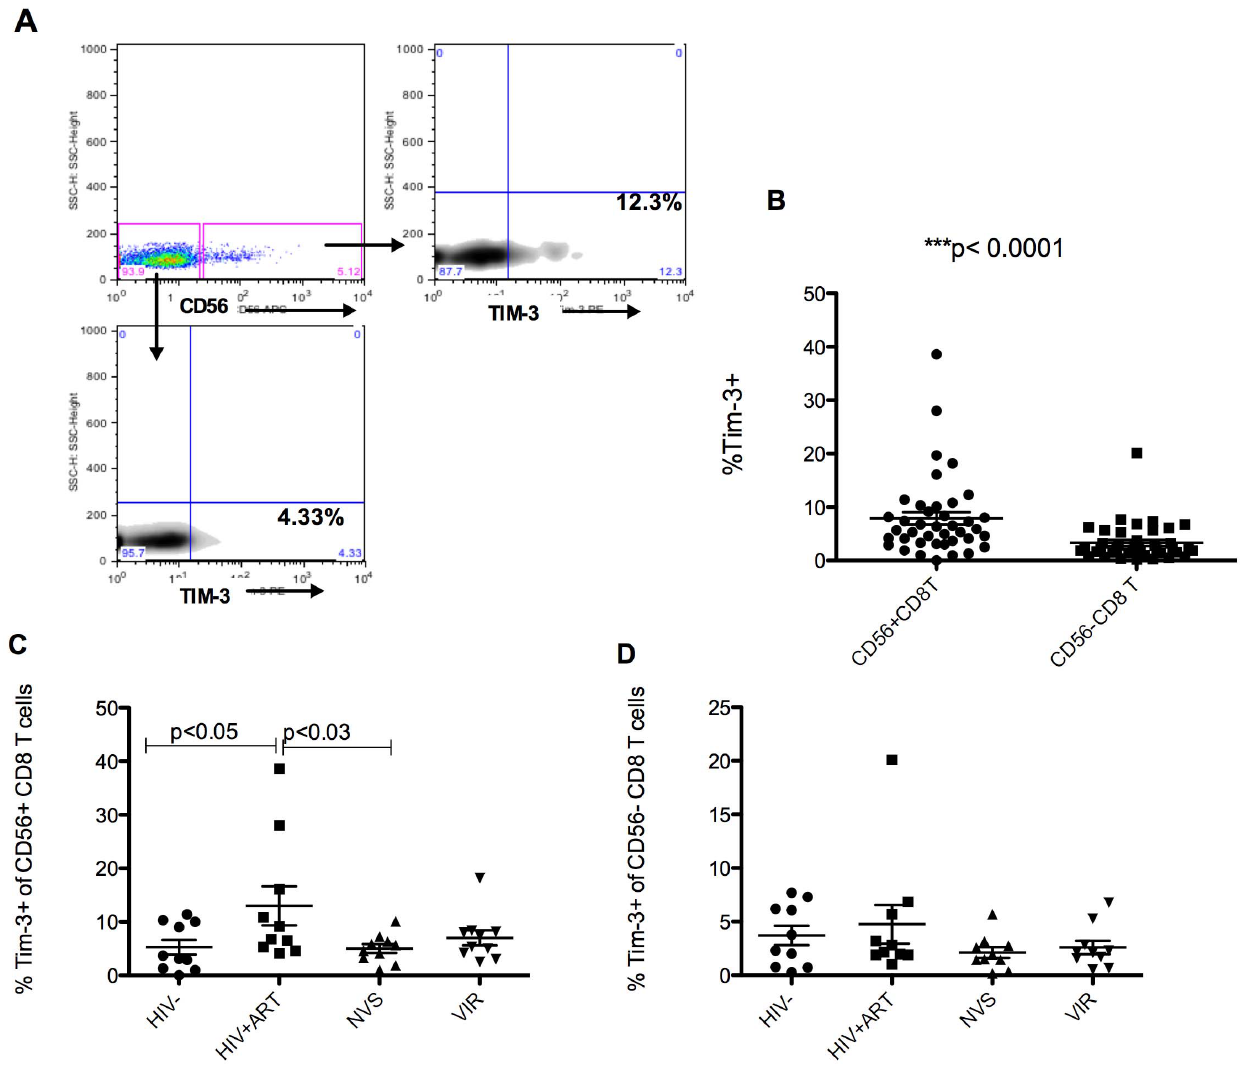
Figure 4. Exhausted CD56 + CD8 T lymphocytes in treated HIV infection. The expression of Tim-3 on T cells identified exhausted T lymphocytes. (A) A higher proportion of CD56 + CD8 T cells express Tim-3 compared to the CD56- subset. (B) Cumulative data from all individuals irrespective of disease status shows significantly higher Tim-3 expression by CD56 + CD8 T cells (C) The proportion of CD56 + CD8 + T cells that are exhausted as judged by their Tim-3 expression were significantly higher in HIV + ART but not in elite controllers when compared to uninfected group. (D) The levels of Tim-3 on CD56- CD8 T cells is comparable in all HIV- and HIV + groups.